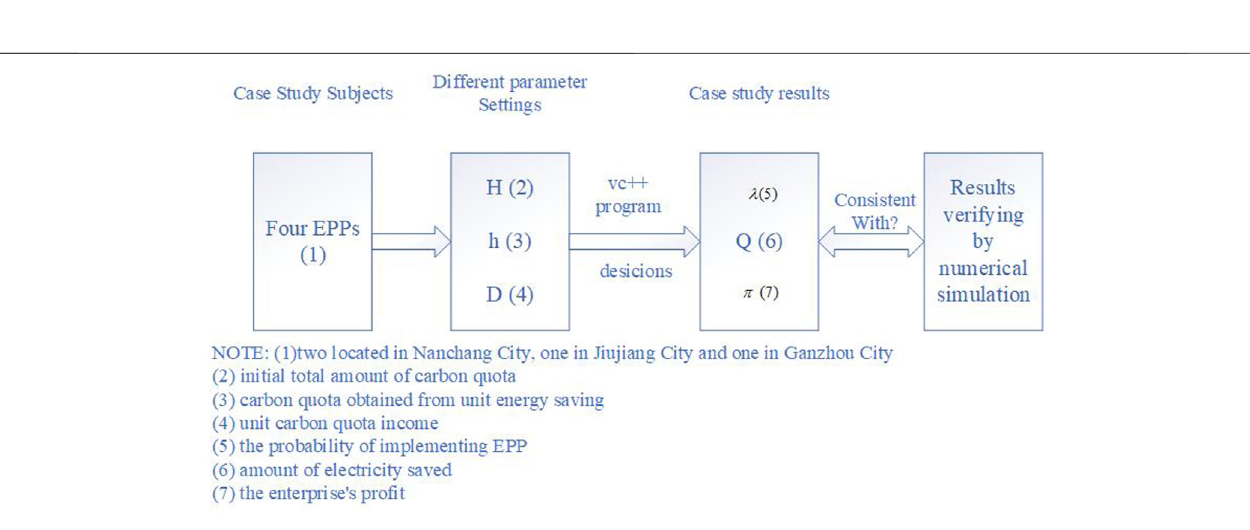
FIGURE 10 | The block diagram of the case